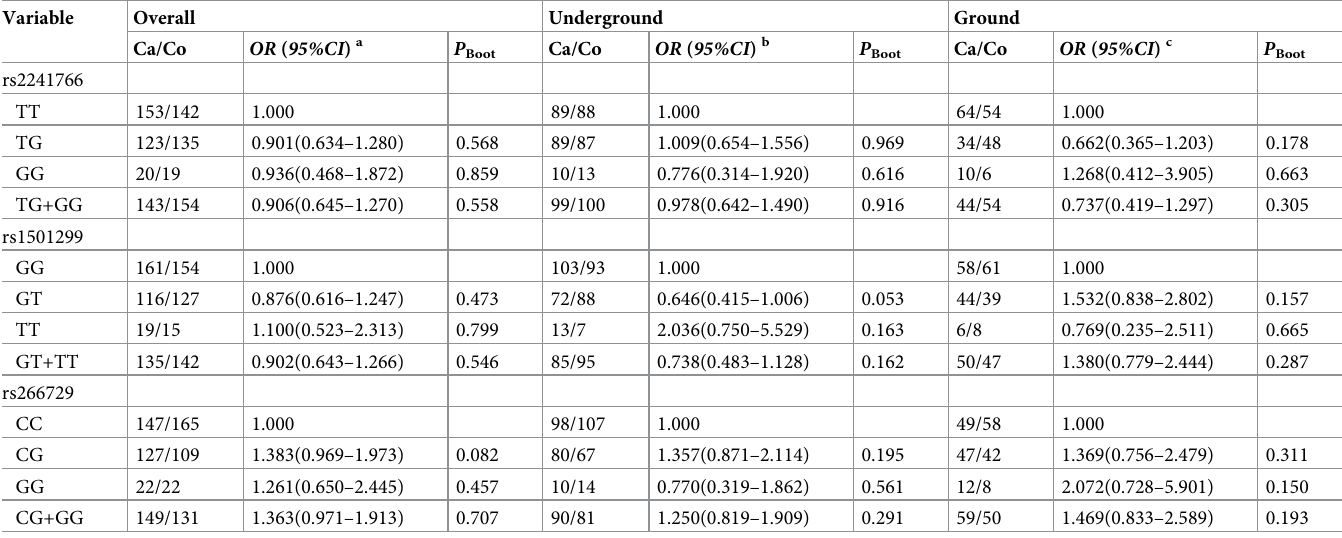
Table 3. Association of hypertension risk with rs2241766, rs1501299, and rs266729. Variable Overall Underground Ground